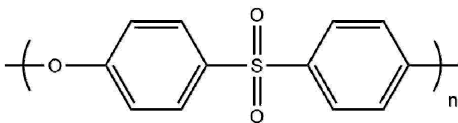
Figure 2. Molecular structure of polyethersulfone.